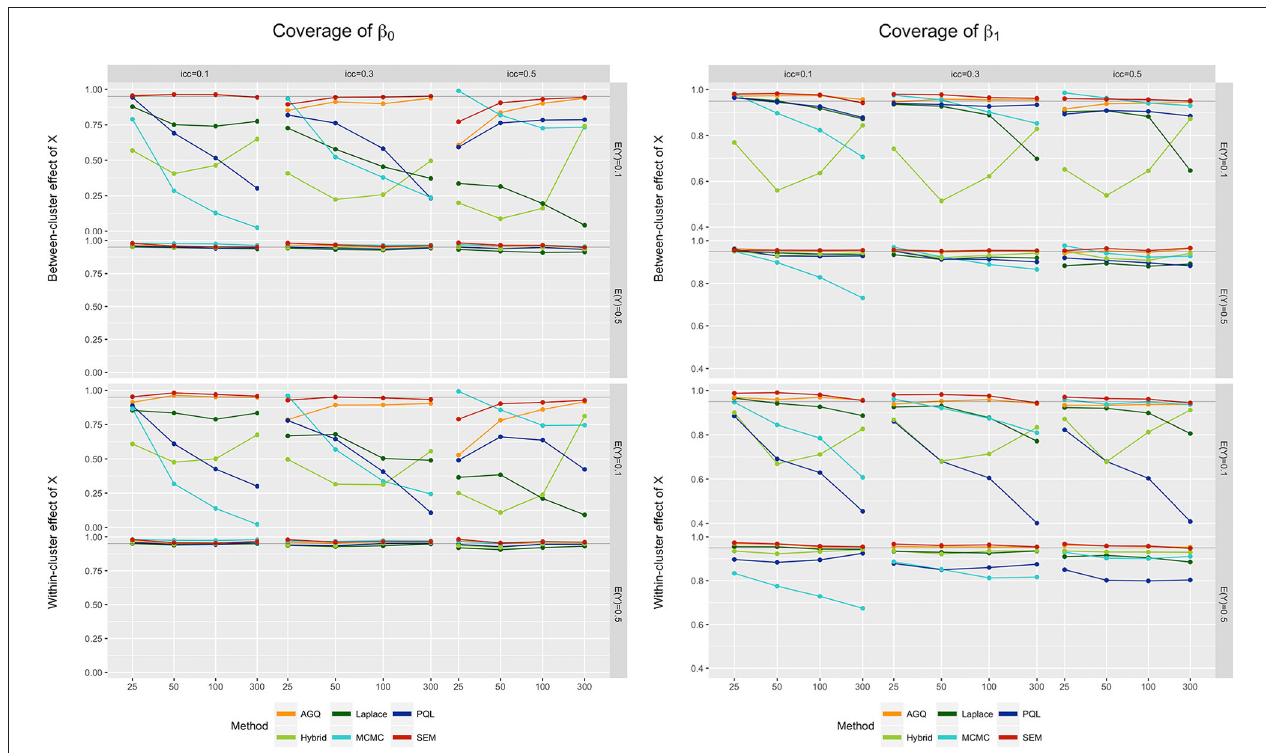
FIGURE 6 | Coverage of β 0 (left) and β 1 (right) for the six approaches, for different measurement levels of X (within- or between clusters), outcome prevalences (0.1 and 0.5), icc l (0.1, 0.3, and 0.5), and sample sizes (25, 50, 100, and 300). These results stem from simulation runs where all methods